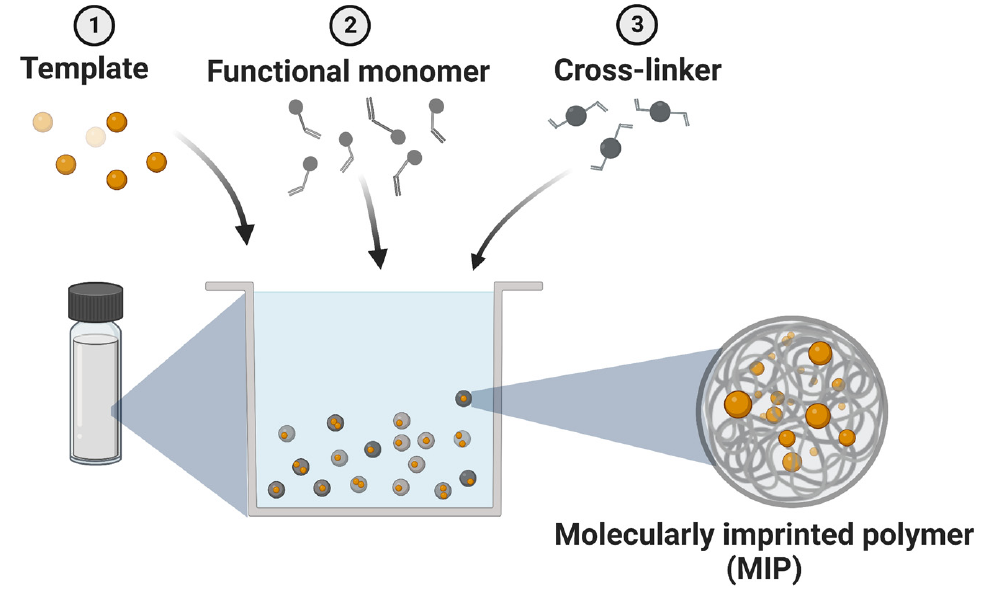
Figure 2. Schematic representation of MIP synthesis. The illustration presents the simplified process of molecular imprinting, wherein a mixture of template, functional monomer and cross-linker generates a highly cross-linked polymer, under certain initiating reaction conditions.